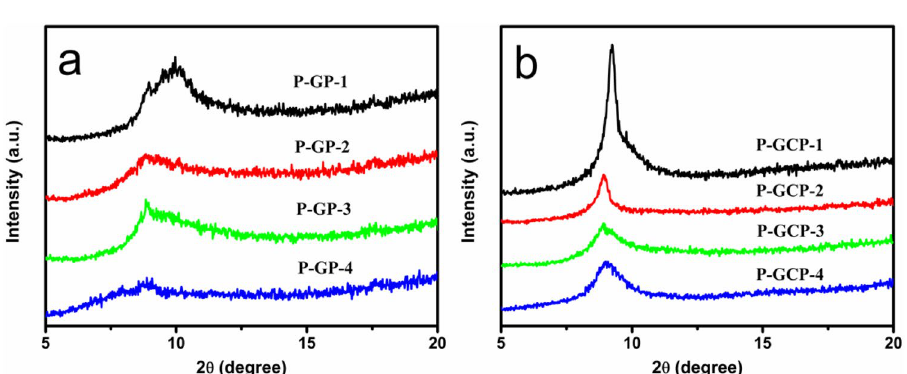
Figure 5. ( a ) XRD patterns of P-GP binary artificial nacre nanocomposites, and ( b ) XRD patterns of P-GCP ternary artificial nacre nanocomposite.